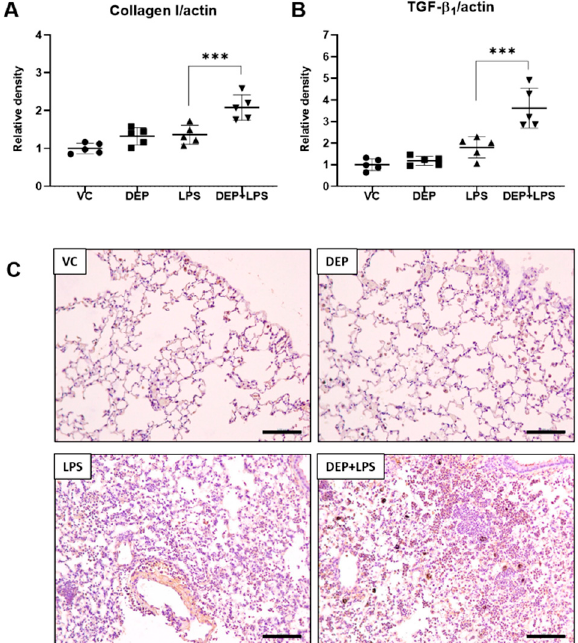
Figure 5. Protein levels of ( A ) collagen I and ( B ) TGF- β 1 and representative images of immunohisto- chemistry for TGF- β 1 (( C ), brown color) in the lung tissue sections from mice in the VC, DEP, LPS, and DEP pre-exposed and LPS-instilled (DEP+LPS) groups. Scale bars = 500 nm. Data represent means ± SD (n = 5 per group). *** p < 0.001 vs. LPS group. Table 2. Immunohistochemical scores for TGF- β 1 and IL-17A. Group